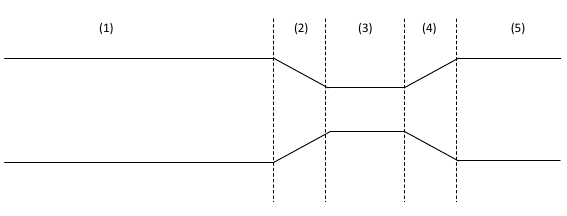
Figure 5: Top view of the venturi flume at